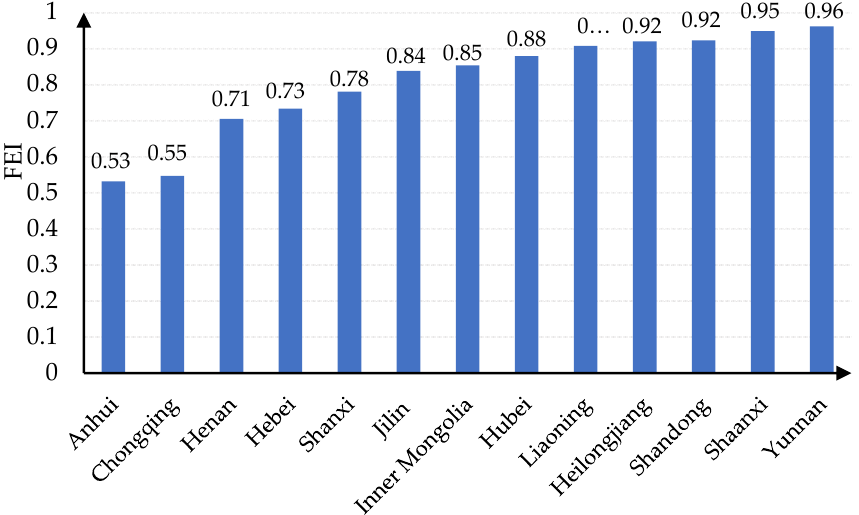
Figure A1. Soybean fertilizer use efficiency in major soybean producing provinces (average value. 2015–2019).